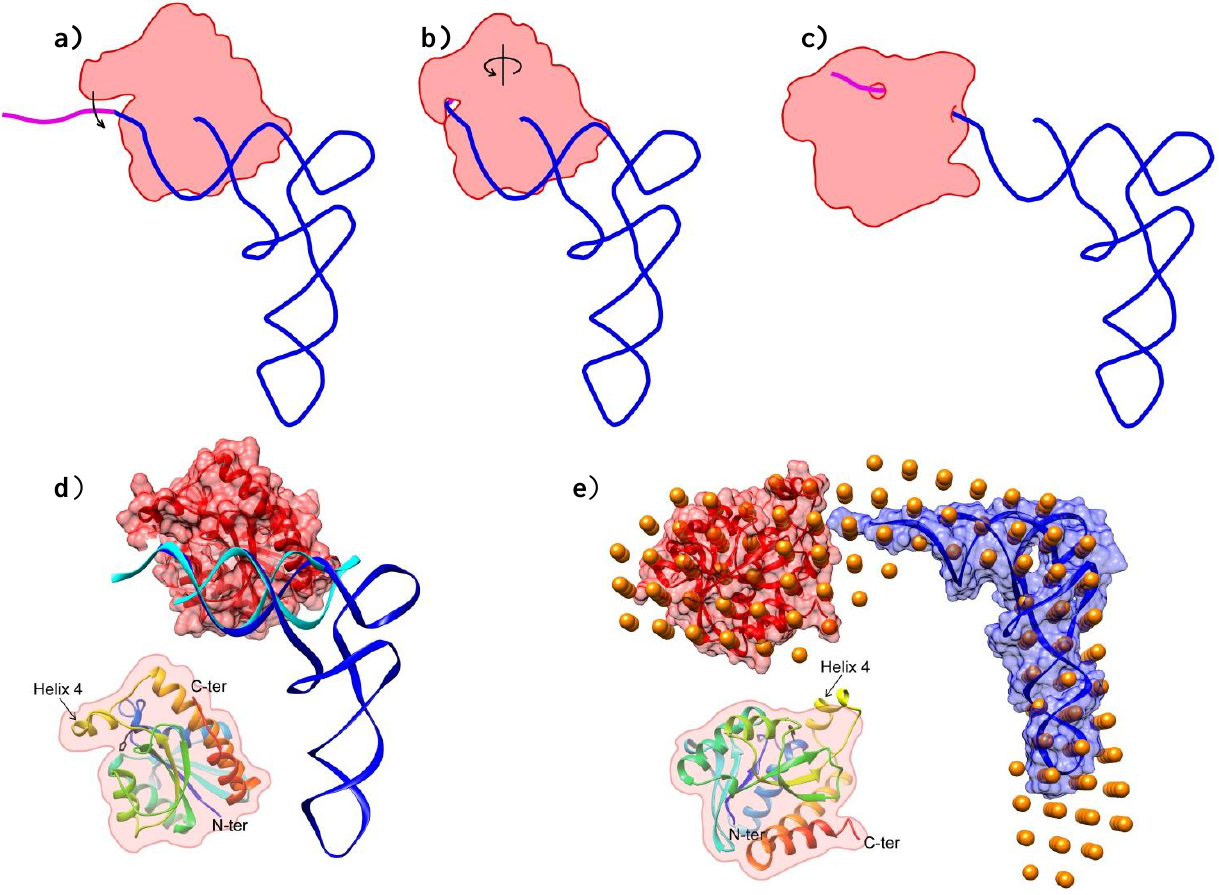
Figure 4. Model of Pth1 Interaction with peptidyl-tRNA. ( a – c ) Cartoon representation of the Pth1 (red) interaction model with peptidyl-tRNA (blue and magenta). ( a ) After substrate recognition; ( b ) helix 4 clamps the peptide portion (magenta) and CCA terminus of the substrate in the binding channel; ( c ) followed by the enzymatic reaction and release of products or just release of the nucleotide as observed in the SANS model; ( d – e ) Available high and low resolution structures of Pth1 and peptidyl-tRNA on which the model of interaction was built; ( d ) Crystal structures of the complex between Pth1 (PDBID:2PTH, red surface) and the TΨC loop of tRNA (PDBID:3VJR, cyan) with tRNA Phe (PDBID:1EHZ, blue) superimposed; ( e ) SANS model (orange beads) of the interaction presented here with the same coloring as in ( d ); Insets show the orientation of Pth1. In black, His20 is the only side chain